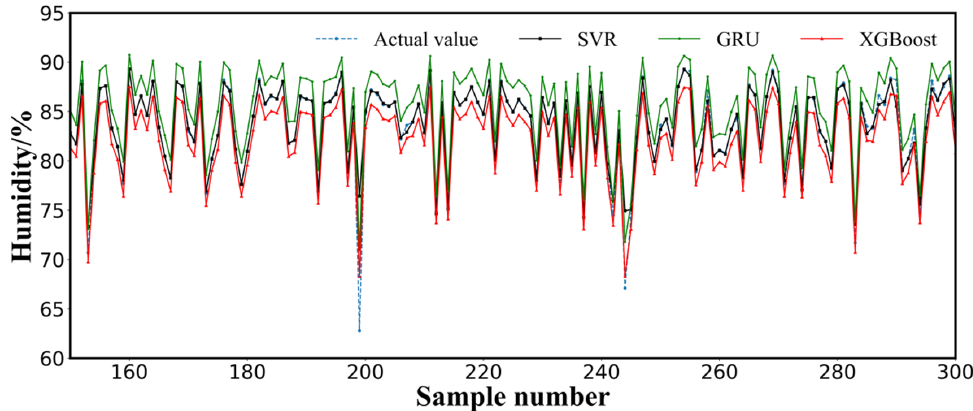
Figure 5. Measured versus computed humidity of GRU, XGBoost, and SVR (part of validation data). When the SVR algorithm hyperparameters were globally searched and optimized using three different search algorithms (i.e., GA, GWO, and CGWO), the SVR algorithm optimized using CGWO exhibited lower MAE, RMSE, MSE, and NRMSE values of 80%, 43%, 73%, and 48%, respectively, compared to the SVR algorithm optimized using GA, whereas R 2 was improved by 1%. Compared with the GWO ‐ optimized SVR algorithm, the MAE, RMSE, MSE, and NRMSE values were reduced by 4%, 30%, 48%, and 28%,